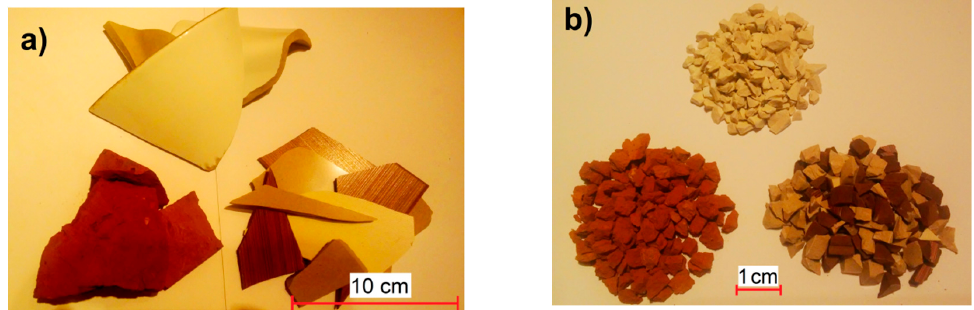
Figure 1. Ceramic waste materials. From the top: sanitary ceramic, red ceramic, and tiling ceramic, ( a ) in the form of waste, ( b ) in the form of coarse aggregate.